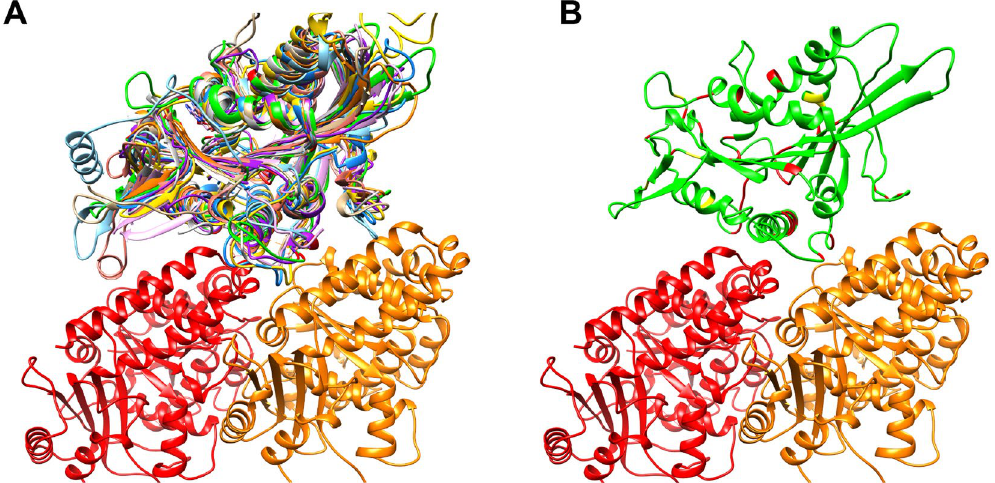
Figure 6. Mutations distribution map. ( A ) The structural alignment for all the kinesin-tubulin dimer structures studied, each color representing a different kinesin structure. ( B ) Mutations sites mapped on a representative kinesin structure (kinesin-3 family member, KIF1A). Red residues indicate disease-causing mutation sites and yellow residues indicate non-disease-causing mutation sites. α -tubulin (red) is on the left and β -tubulin (orange) is on the right in both panels.